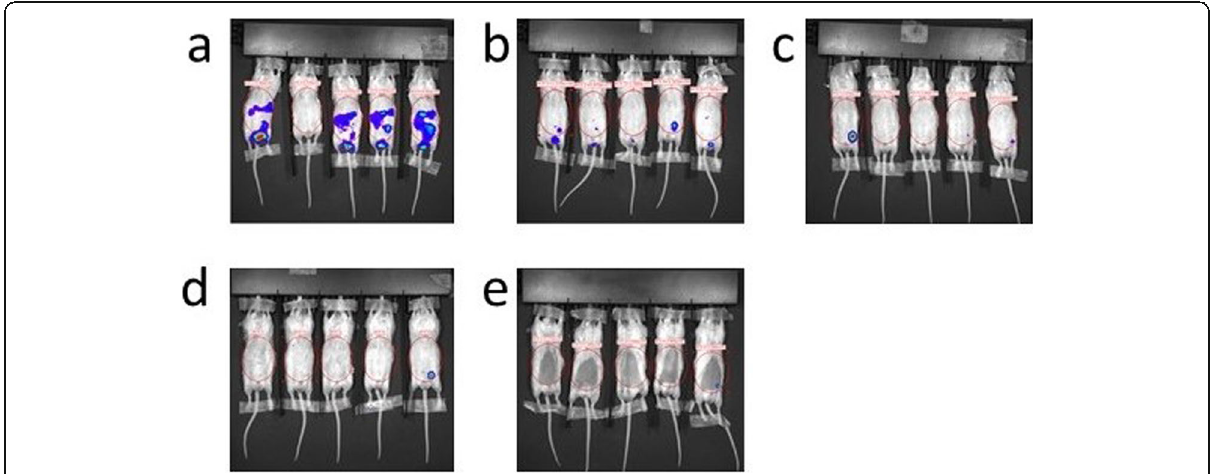
Fig. 4 Optical imaging during acquisition. Five representative BoxA-treated mice of the second experiment. Panels a , b , c , d , and e : day 1, 3, 6, 30, and 34 from injection, respectively. From a to e , a reduction of the OI signal due to the protective role of BoxA treatment can be